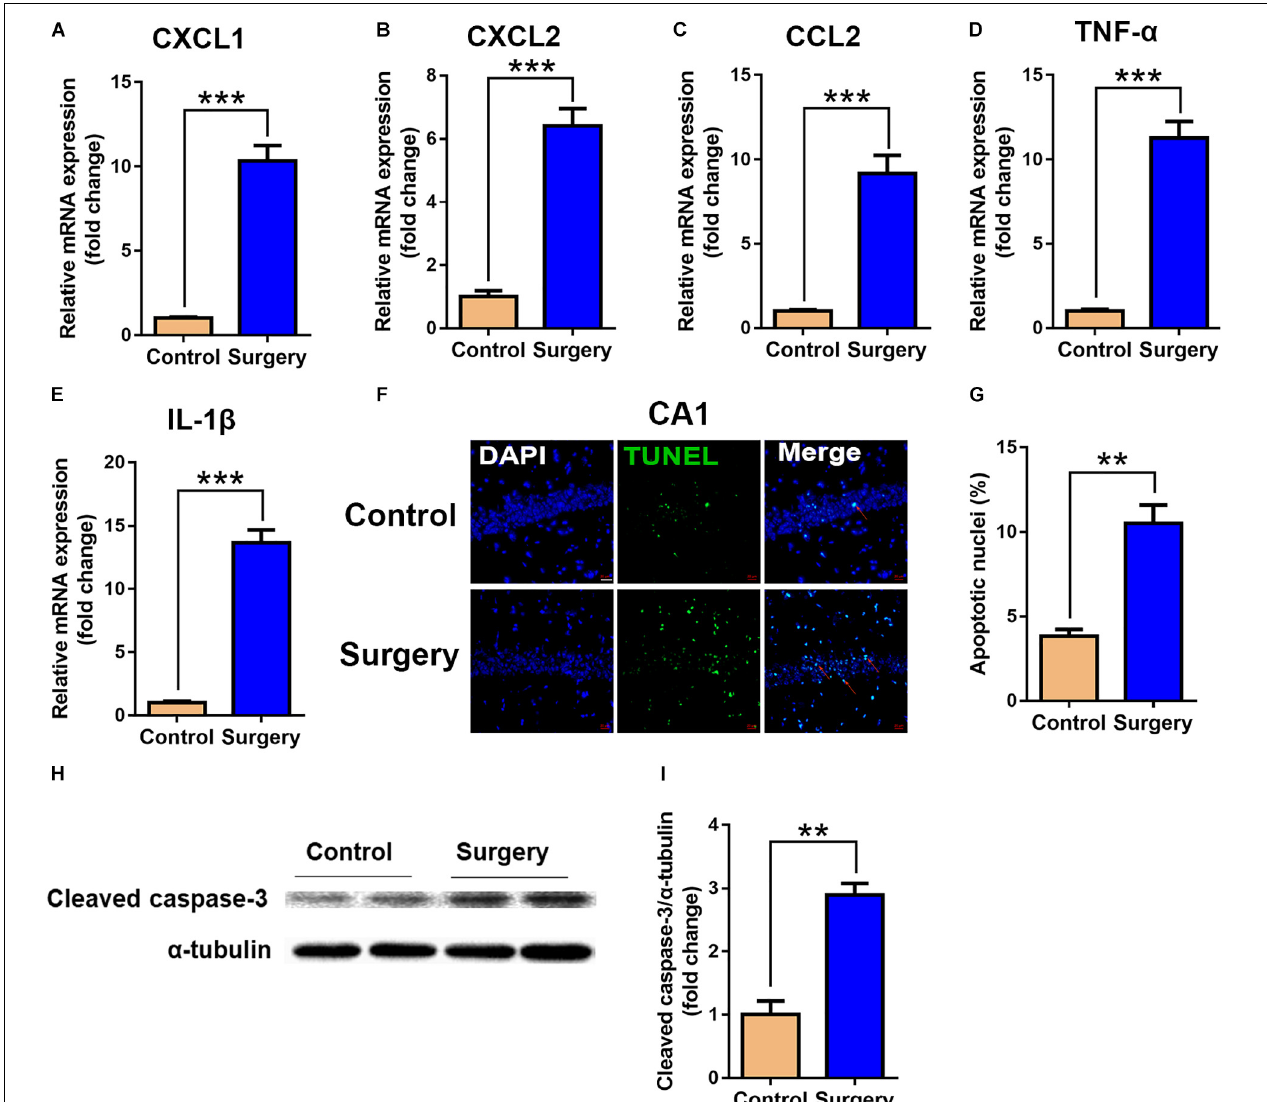
FIGURE 5 | Expression of inflammatory cytokines and neuronal apoptosis were significantly enhanced in hippocampal tissue after surgery. Hippocampal tissues were harvested on day 3 after surgery from the two groups. (A–E) mRNA expression of CXCL1 (A), CXCL2 (B) , CCL2 (C) , TNF- α (D) and IL-1 β (E) . Proinflammatory cytokine expression was measured by qRT-PCR. (F) Representative images of TUNEL assay in the CA1 of the hippocampus. Scale bar, 20 µ m. (G) Quantitative analysis of TUNEL-positive cells. Red arrows point to representative TUNEL-positive cells. The cells were counterstained with 4’, 6-diamidino-2-phenylindole (DAPI). (H) Protein levels of cleaved caspase-3. (I) Quantification of protein levels of cleaved caspase-3. Data are presented as means ± SEM; ∗∗ P < 0.01, ∗∗∗ P < 0.001, vs. Control, Student’s t -test, N = 6 for all